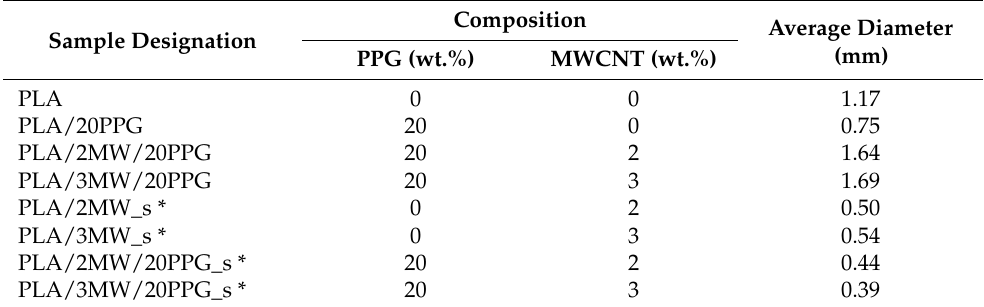
Table 2. Melt-extruded PLA/multiwall carbon nanotube (MWCNT)/ poly(propylene) glycol (PPG)